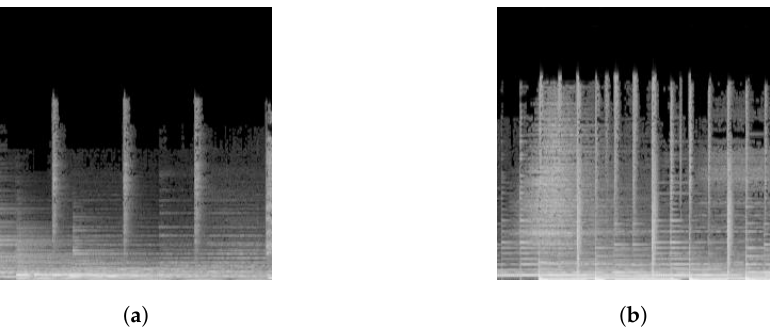
Figure 3. ( a ) the mel-spectrogram of an audio signal for a song with the Downtempo genre; ( b ) the mel-spectrogram of an audio signal for a song with the Rock